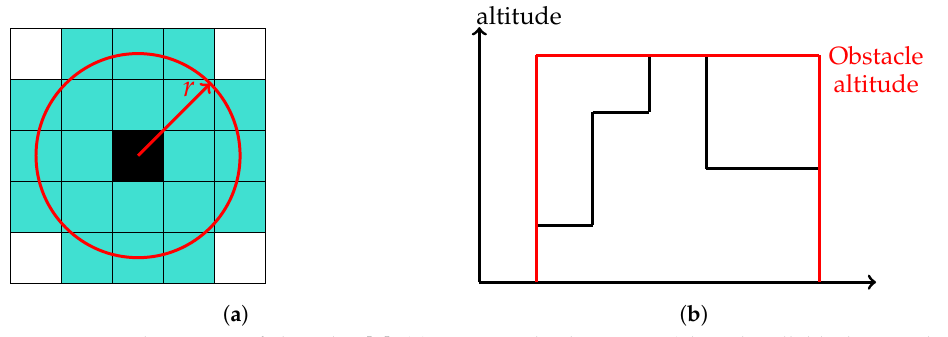
Figure 12. Enlargement of obstacles [7]. ( a ) Horizontal enlargement (obstacle cell: black, new obstacle cells: blue); ( b ) vertical enlargement.